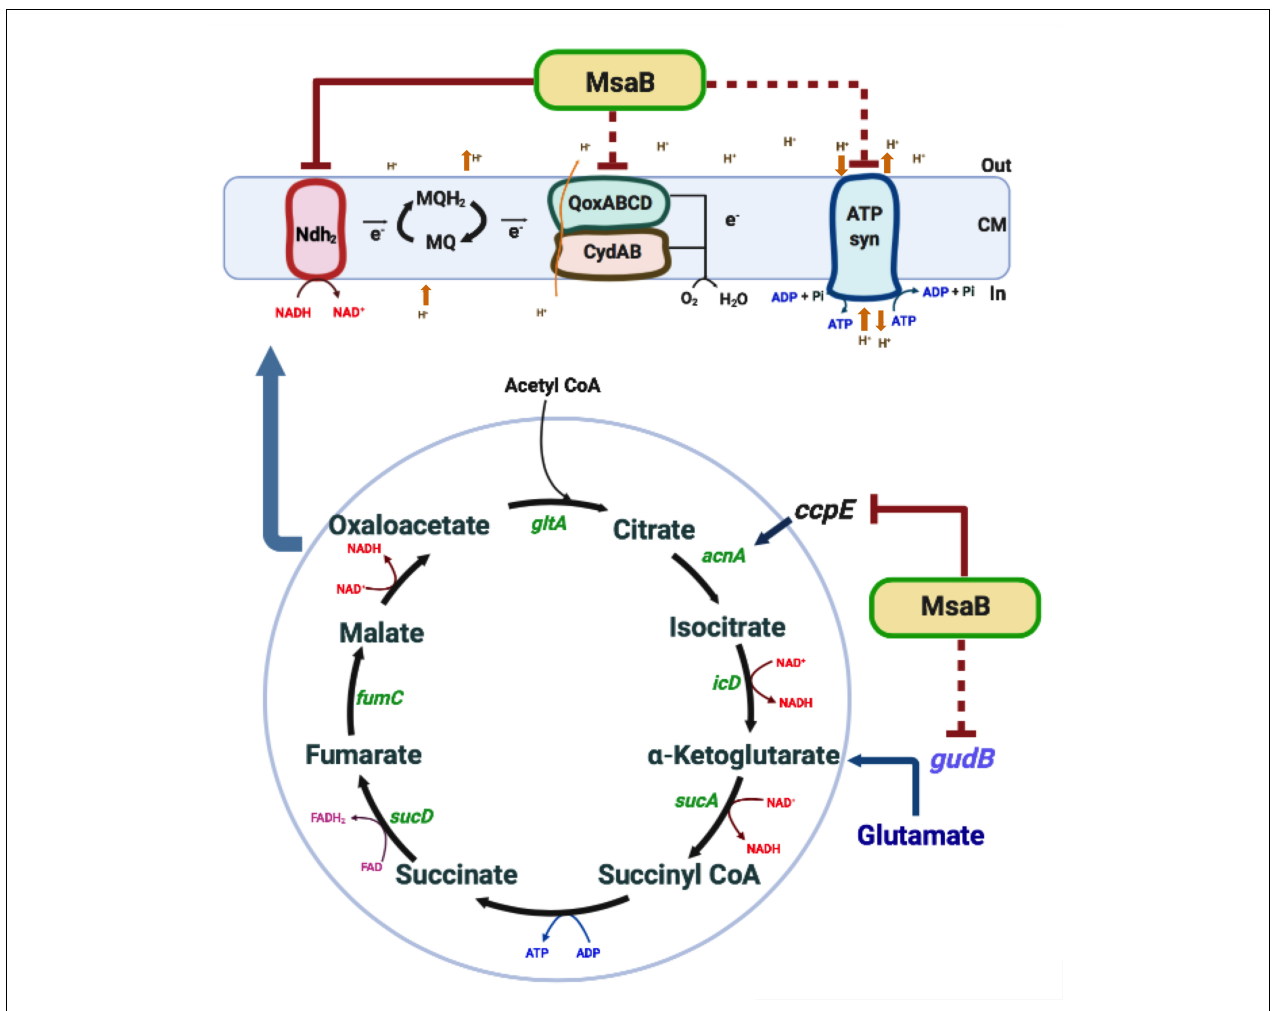
FIGURE 9 | Overview of msaABCR (MsaB) regulation of energy metabolism. Inactivation of msaABCR in S. aureus upregulates ccpE , which in turn positively regulates acnA expression. The consequent increased activation of the TCA cycle results in increased ATP and NADH. Oxidation of NADH, in turn, increases the membrane potential. MsaB also controls the expression of the ETC gene ndh 2 as an RNA chaperone. This process leads subsequently to the biosynthesis of ATP by the F0F1 ATPase in S. aureus